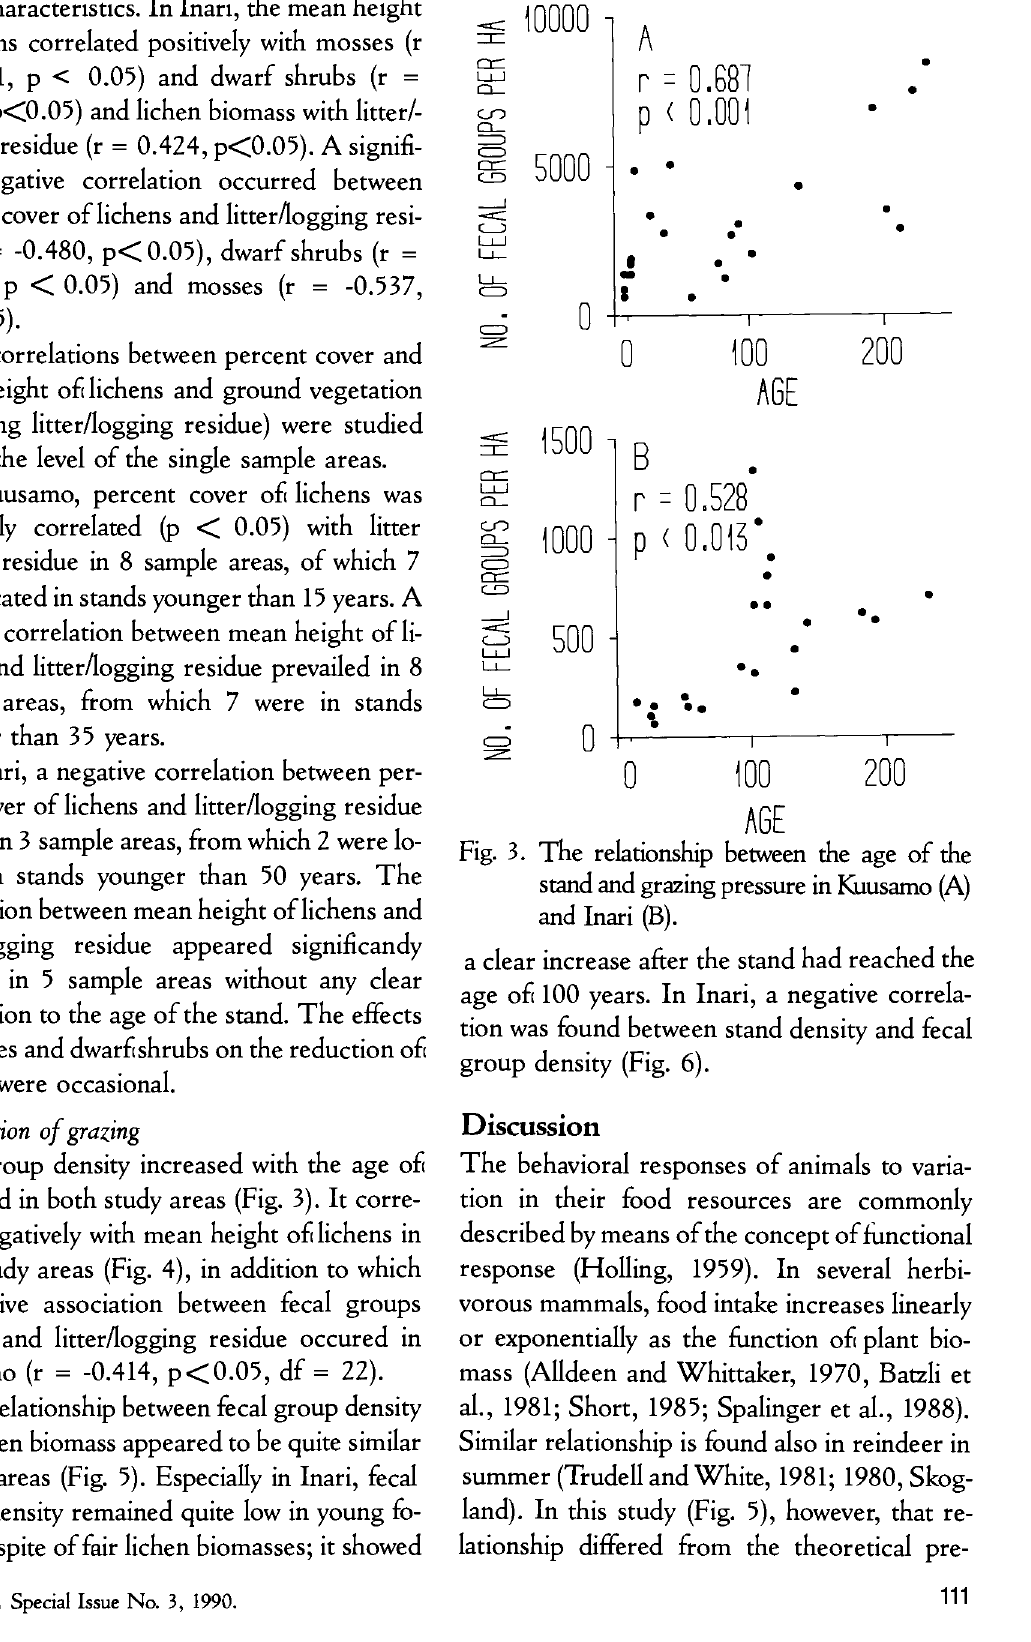
Fig. 3. The relationship between the age of the stand and grazing pressure in Kuusamo (A) and Inari